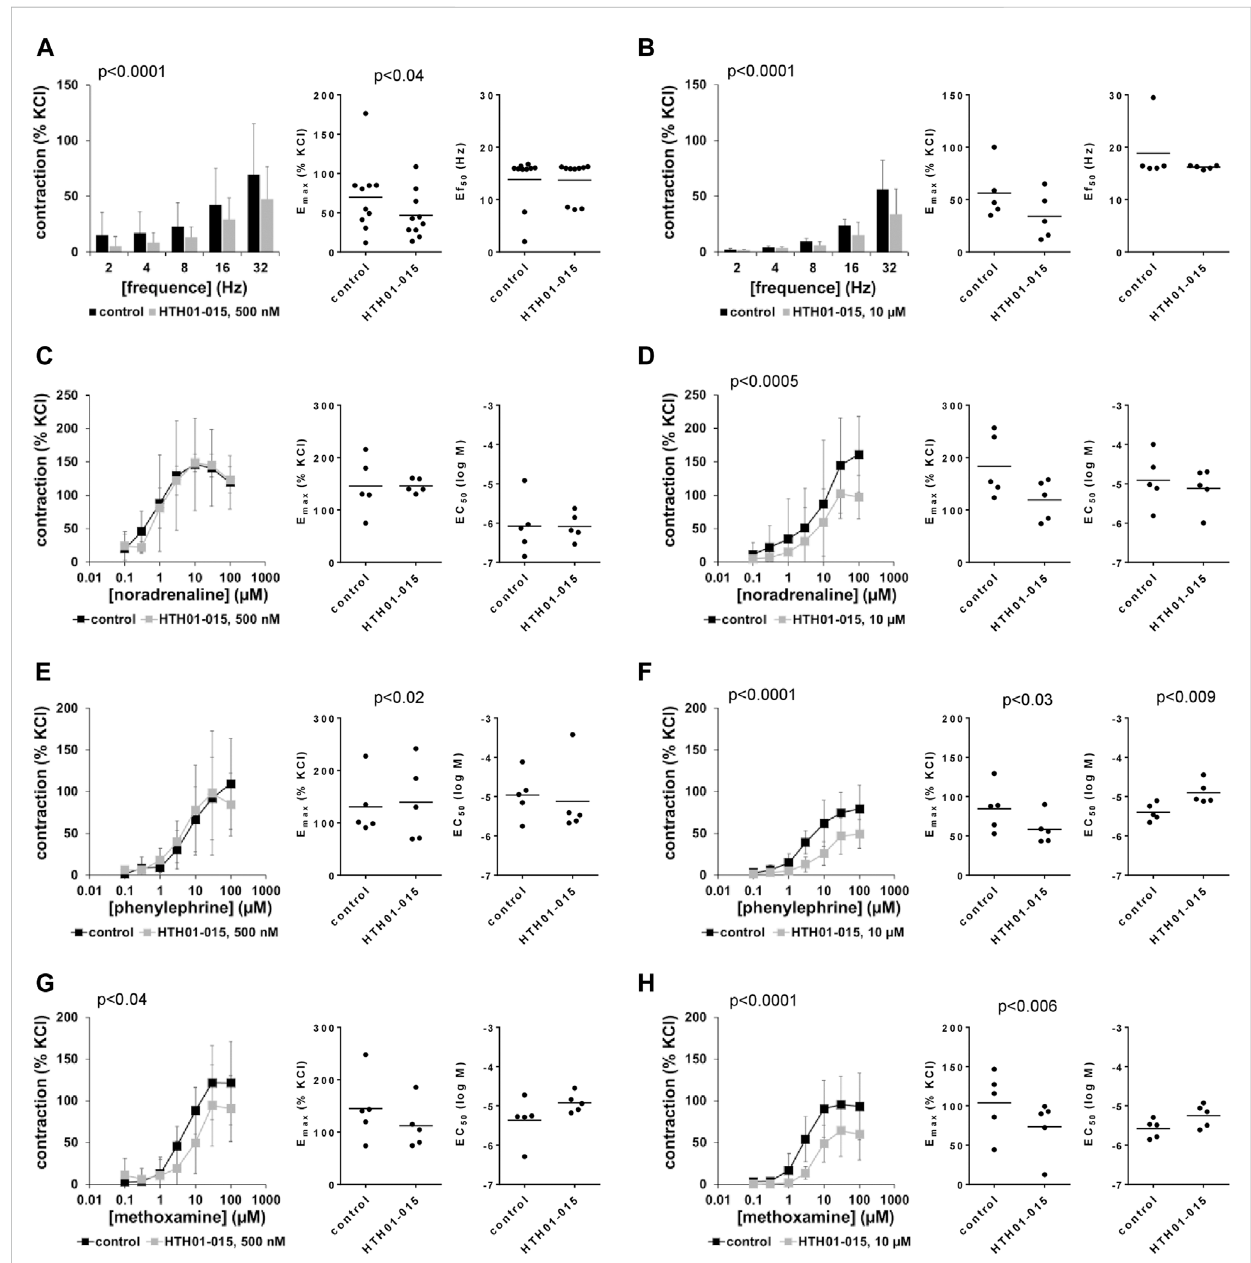
FIGURE 8 Effects of HTH01-015 on EFS-induced and adrenergic contractions of human prostate tissues. Contractions of human prostate tissues were induced by EFS (A,B) , noradrenaline (C,D) , phenylephrine (E,F) or methoxamine (G,H) in an organ bath, 30 min after addition of HTH01-015 in concentrationsof500 nM (A,C,E,G) or10 µM (B,D,F,H) orofanequivalentamountofDMSO(controls),whichwasusedassolventforHTH01-015.Shown are data from n = 10 independent experiments in (A) and n = 5 independent experiments in each other subpanel, where tissues from n = 10 or n = 5 patients were used for both groups of a subpanel, resulting in paired samples. Shown are means ± SD from all experiments in concentration response curves with p values from two-way ANOVA for whole groups, and all single E max , EC 50 and Ef 50 values from all experiments (calculated by curve fi tting) together with p values from Student ’ s t -test in scatter